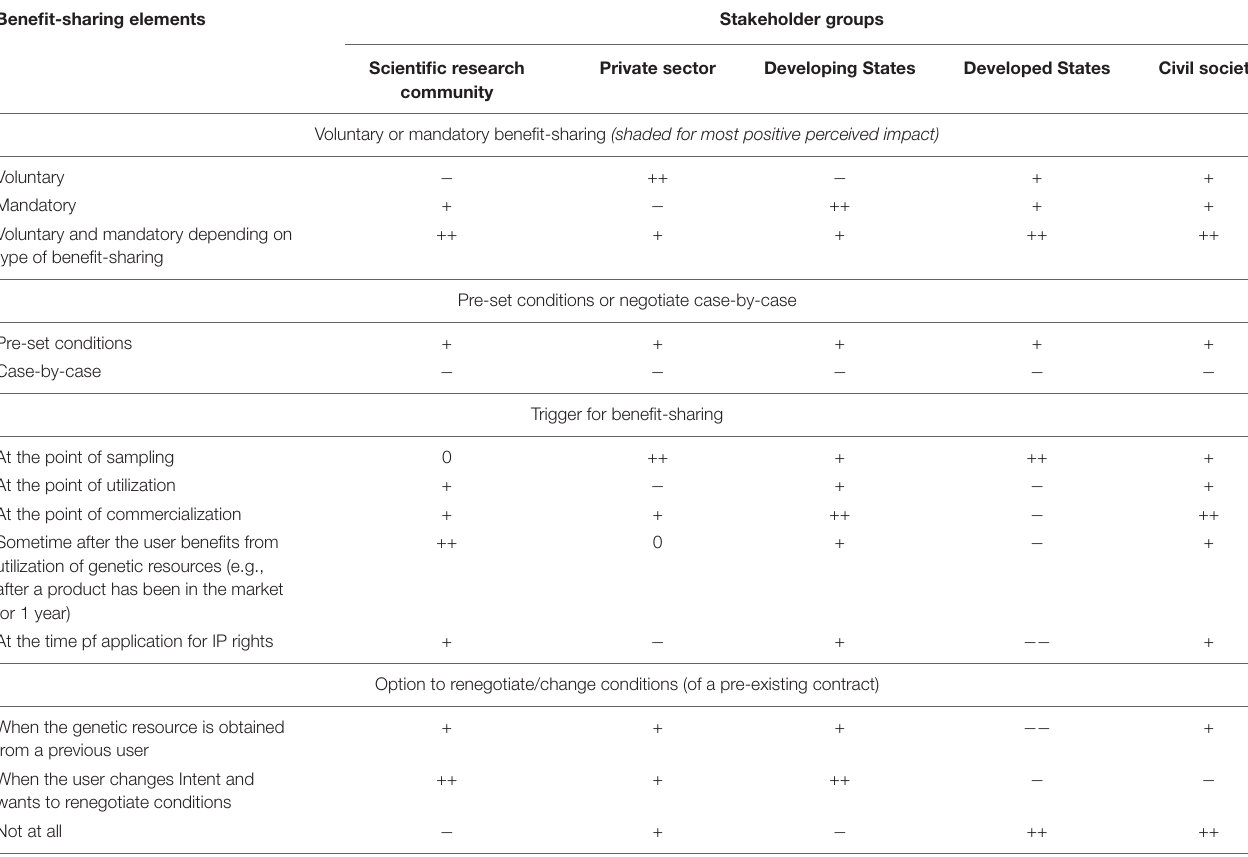
TABLE 5 | Stakeholder perspectives on elements and options related to benefit-sharing in the context of MGR from